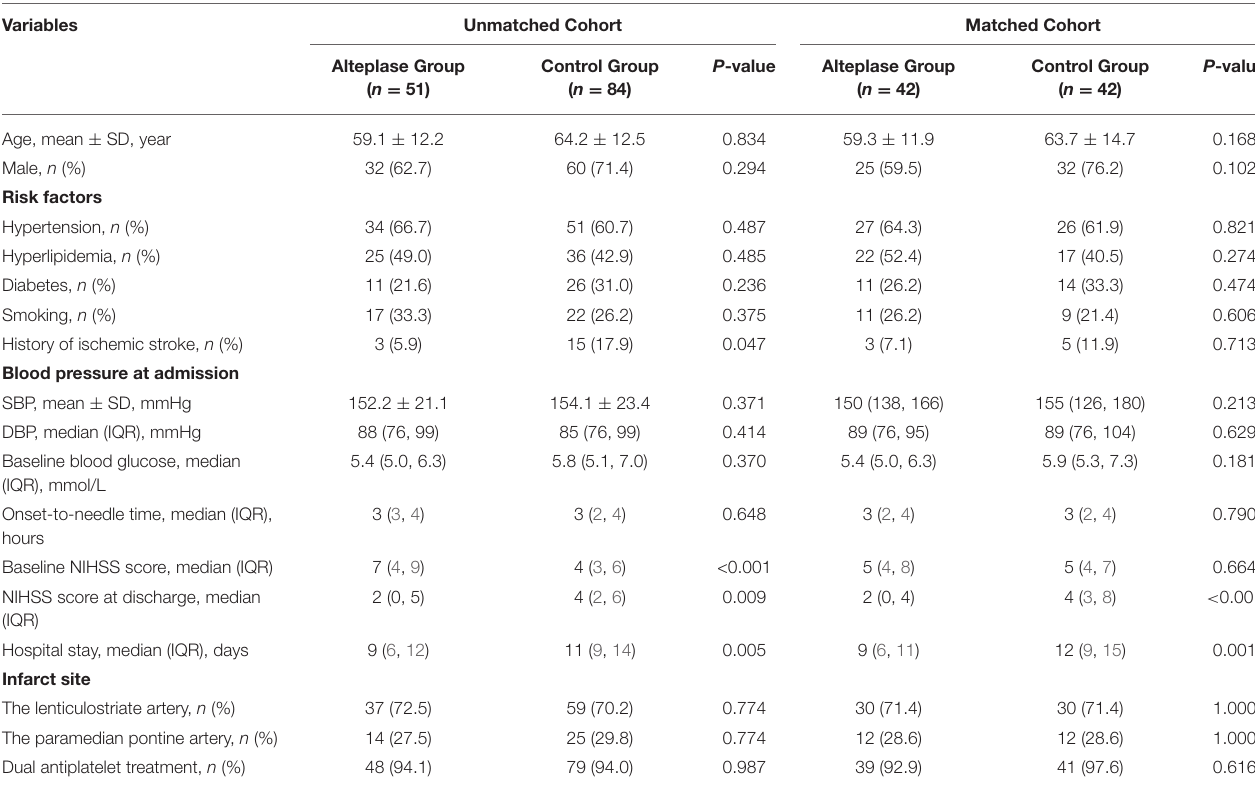
TABLE 1 | The demographics and clinical characteristics of patients with branch atheromatous disease.